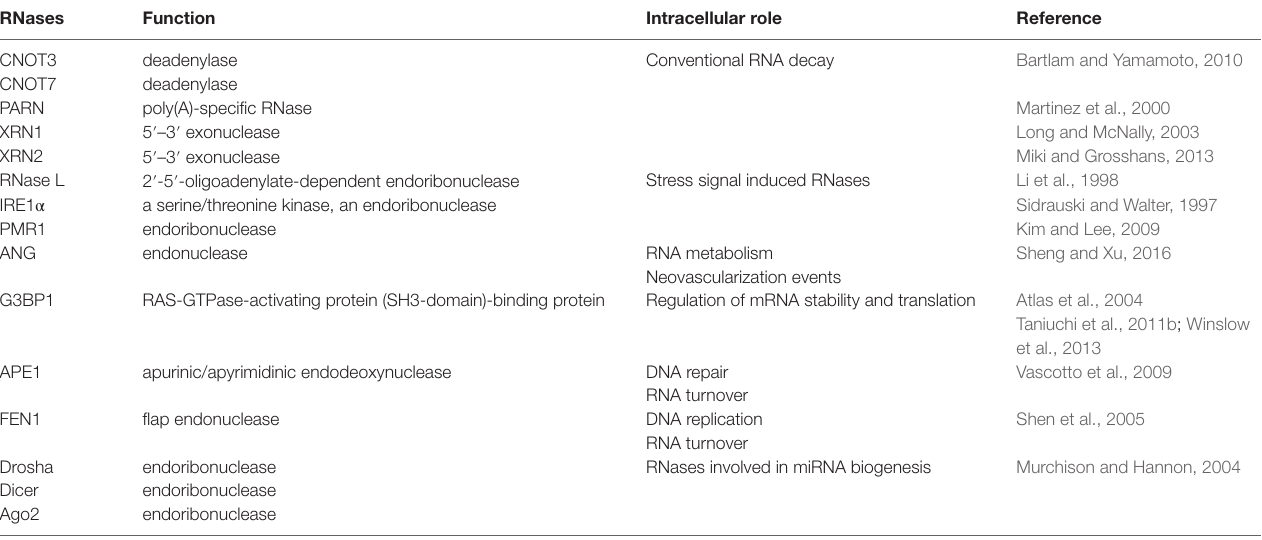
TABLE 1 | Endogenous RNases and other proteins with ribonuclease activity participating in maintenance of normal RNA homeostasis of eukaryotic cells. RNases